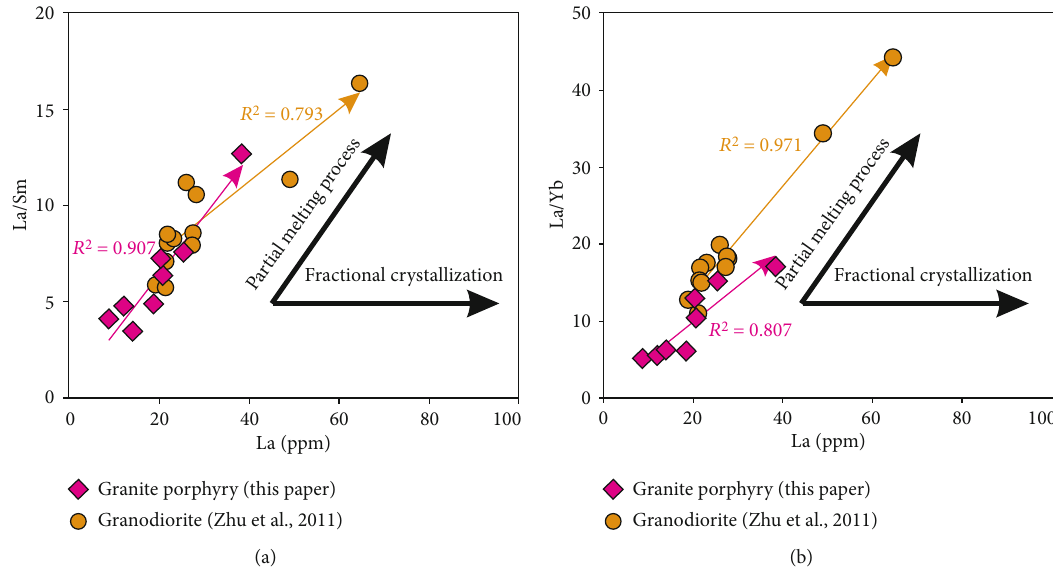
Figure 21: Plot of La vs. La/Sm and La vs. La/Yb for the granite porphyries and granodiorite of the Yangla copper deposit, Yunnan,